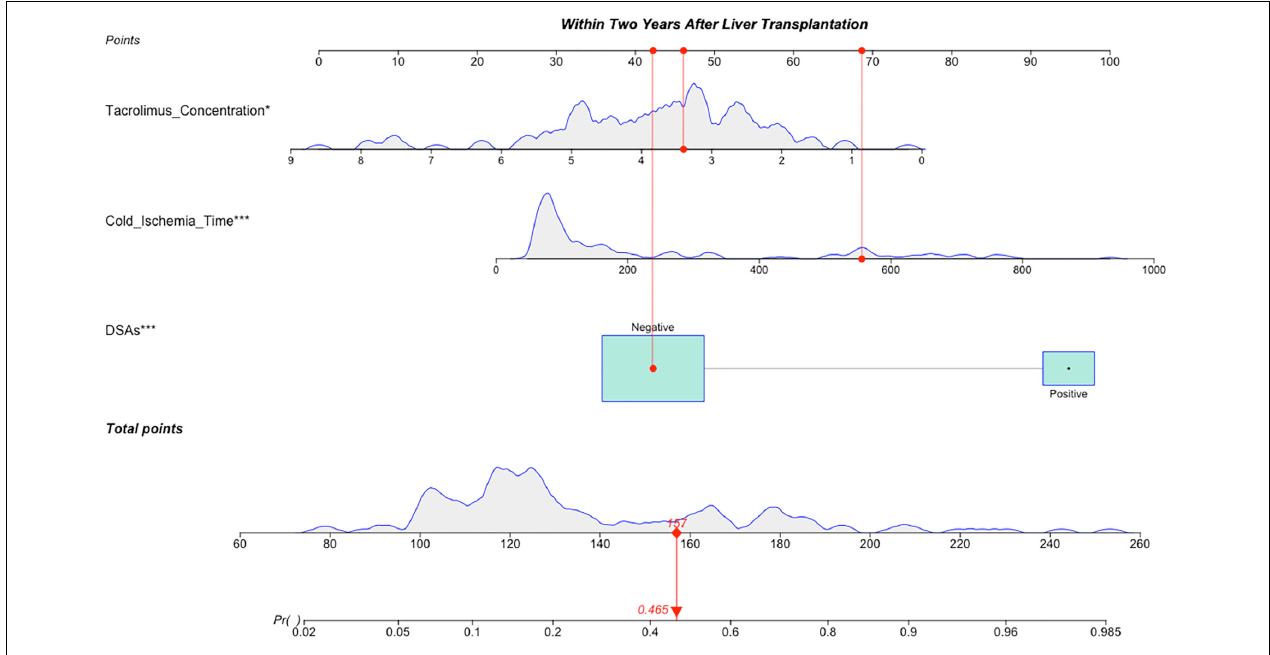
FIGURE 2 | A constructed nomogram for LACR prediction > 1 ≤ 2 years after pLT. The “example” patient’s cold ischemia time was 556 min, DSAs were negative and tacrolimus concentration at 1–2 years after transplantation was 3.4 ng/mL. Density plot of tacrolimus concentration, cold ischemia time and total points shows their distributions. For DSAs, the distribution is reflected by the size of the box. The degree of influence was arranged from top to bottom. In order to use the nomogram, the specific points (red dots) of individual patients are located on each variable axis according to the clinical datum. The red dots of each variable are reflected upward on the Points axis; the sum of these points (157) is located on the Total Points axis, and a line is drawn down to the Probability axis to determine the probability of LACR. In this example, 0.465. LACR, late-onset acute cellular rejection; DSAs, donor-specific antibodies. * p -value < 0.05; ** p -value < 0.01; *** p -value <